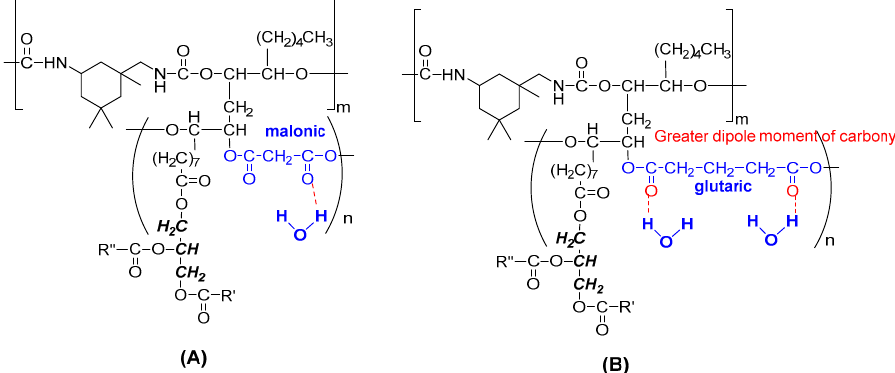
Figure 9. Hypothesised hydrogen bonding formed between ester groups of the ( A ) malonic acid moiety ( B ) glutaric acid in the soft segment of the polyurethanes with water molecules during the enzymatic degradation study.